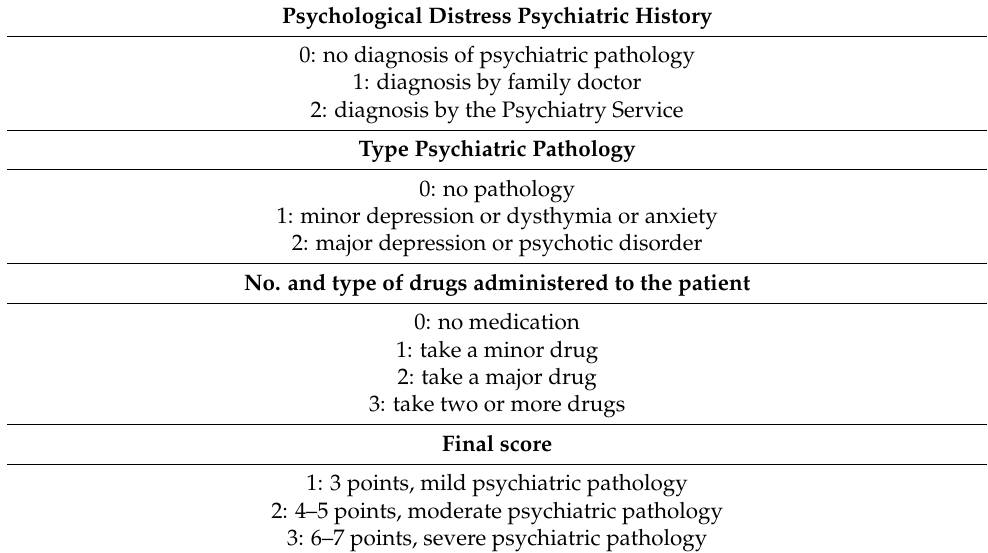
Table 1. Psychological distress